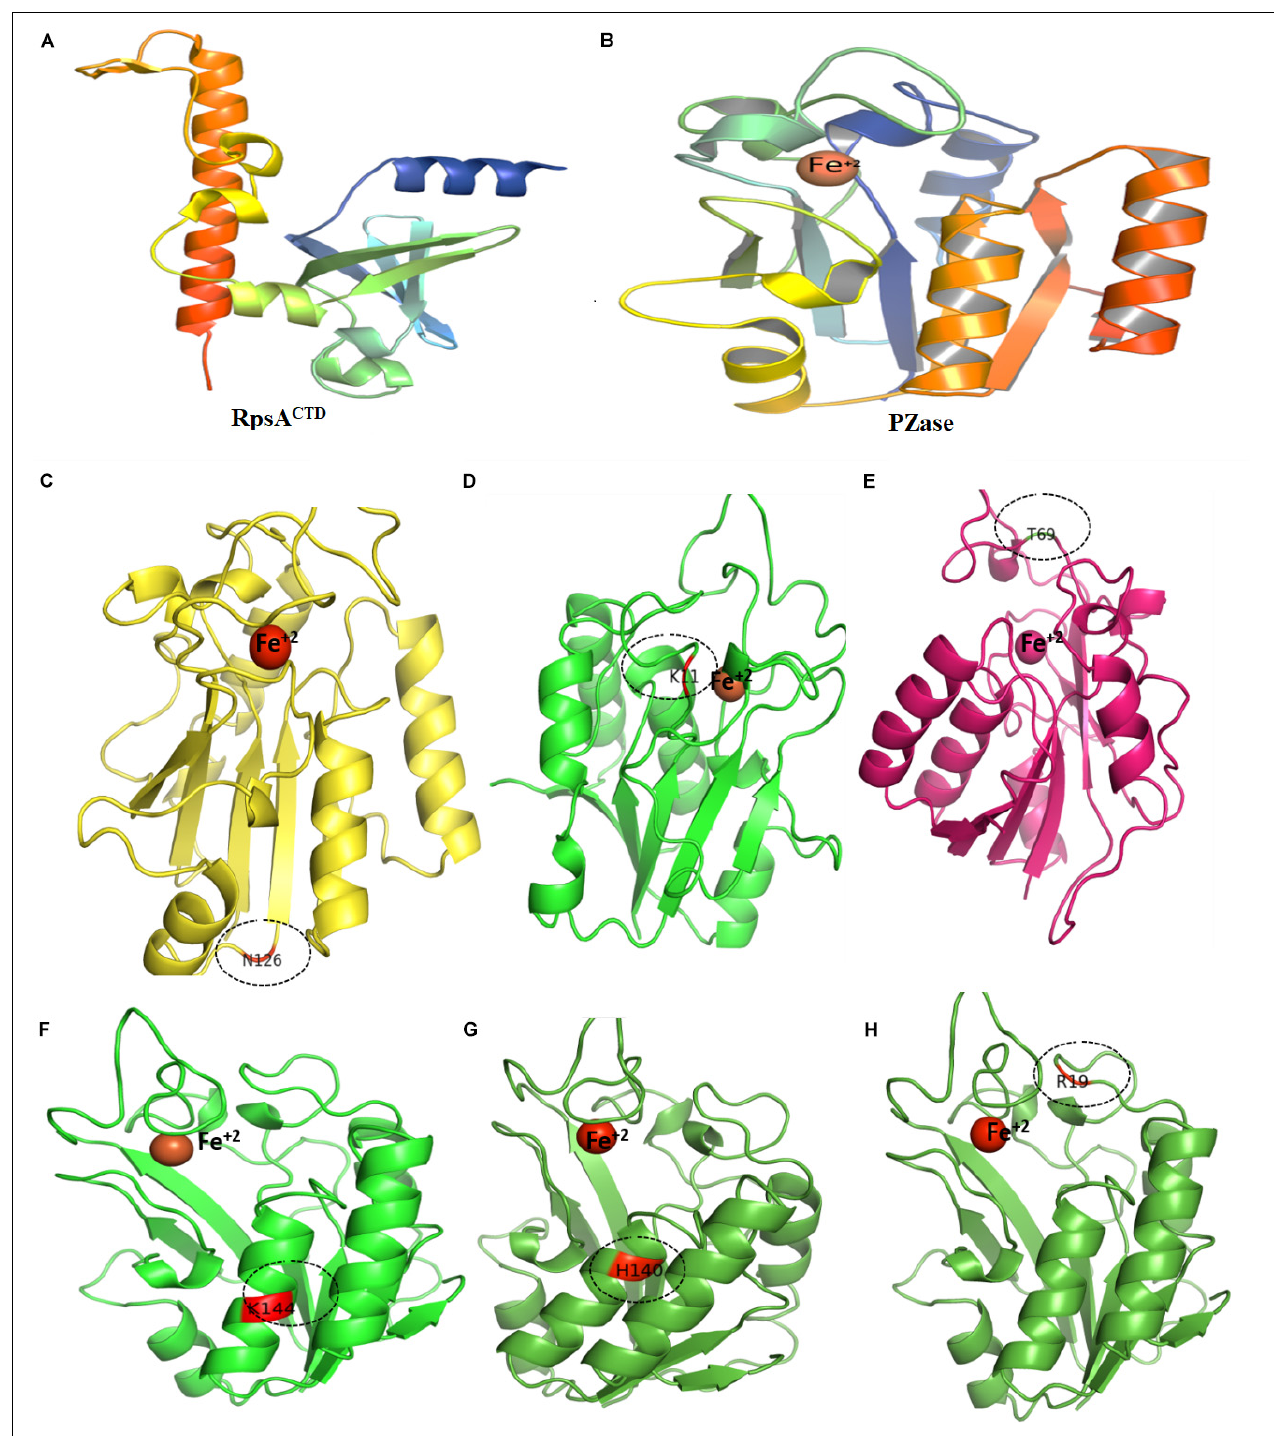
FIGURE 6 | Wild type and mutants PZase structures. Majority of the MTs have been detected in the loop region except (F,G) . Fe + 2 ion parameters have been adjusted in Supplementary Table 1 .